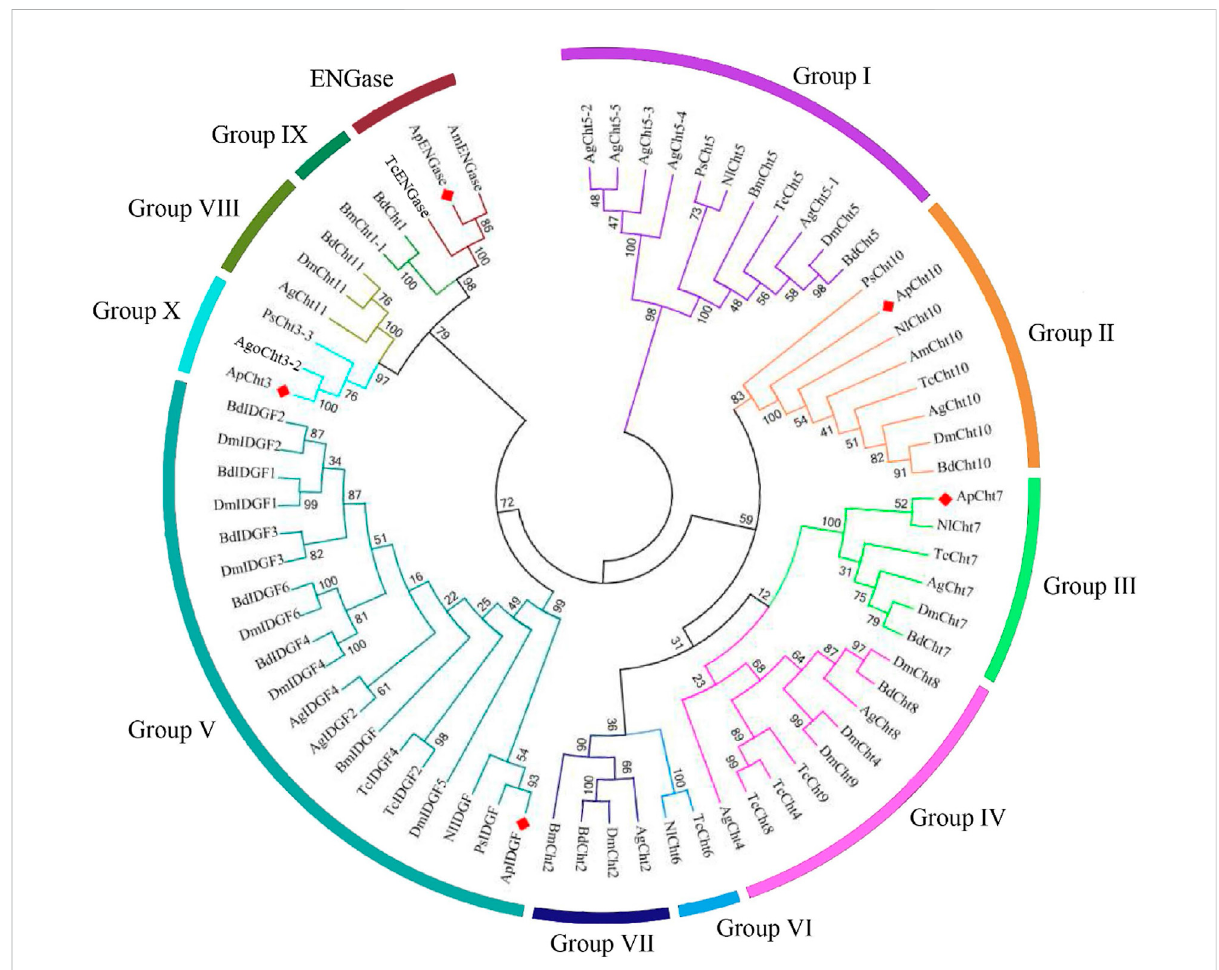
FIGURE 1 Phylogenetic analysis of chitinase genes from 10 different insects. Acyrthosiphon pisum (Ap), Anopheles gambiae (Ag), Drosophila melanogaster (Dm), Triboliumcastaneum (Tc), Bombyxmori (Bm), Phenacoccussolenopsis (Ps), Aphisgossypii (Ago), Apismellifera (Am), Bactrocera dorsalis (Bd), Nilaparvata lugens